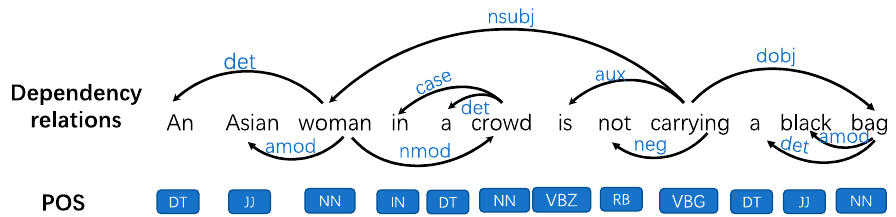
Figure 1. An example of dependency parsing. The dependency relation between two words is represented by a directed arc. Meanwhile, the part-of-speech (POS) of each word is also